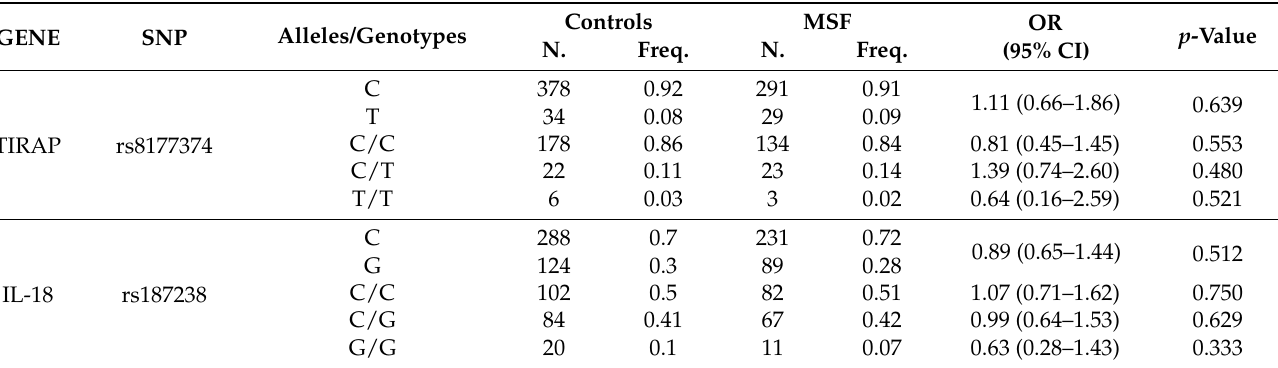
Table 3. Analysis of allele and genotype frequencies (Freq.) of TIRAP rs8177374C/T , TNF rs1800629